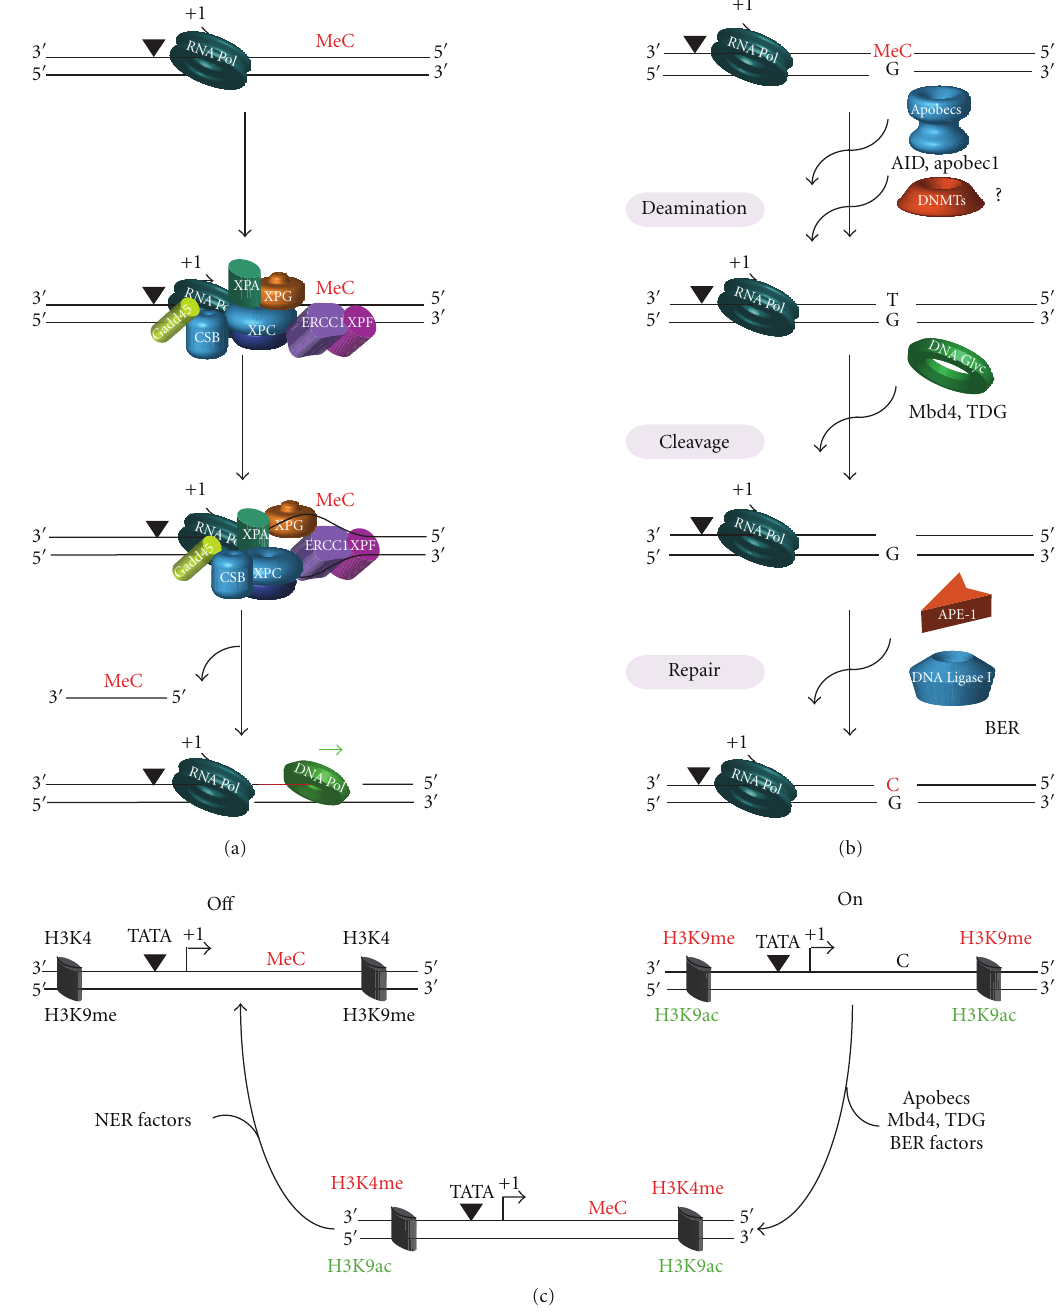
Figure 4: Potential mechanisms of cytosine demethylation. (a) The NER machinery, recruited to the preinitiation complex, can recognize the 5-methyl cytosine (meC) as a NER-specific substrate, in the presence of Gadd45 α , and eliminate it in a process closely related to the canonical NER process with the incision/excision of the oligonucleotide containing the meC. (b) Another pathway involves two steps;